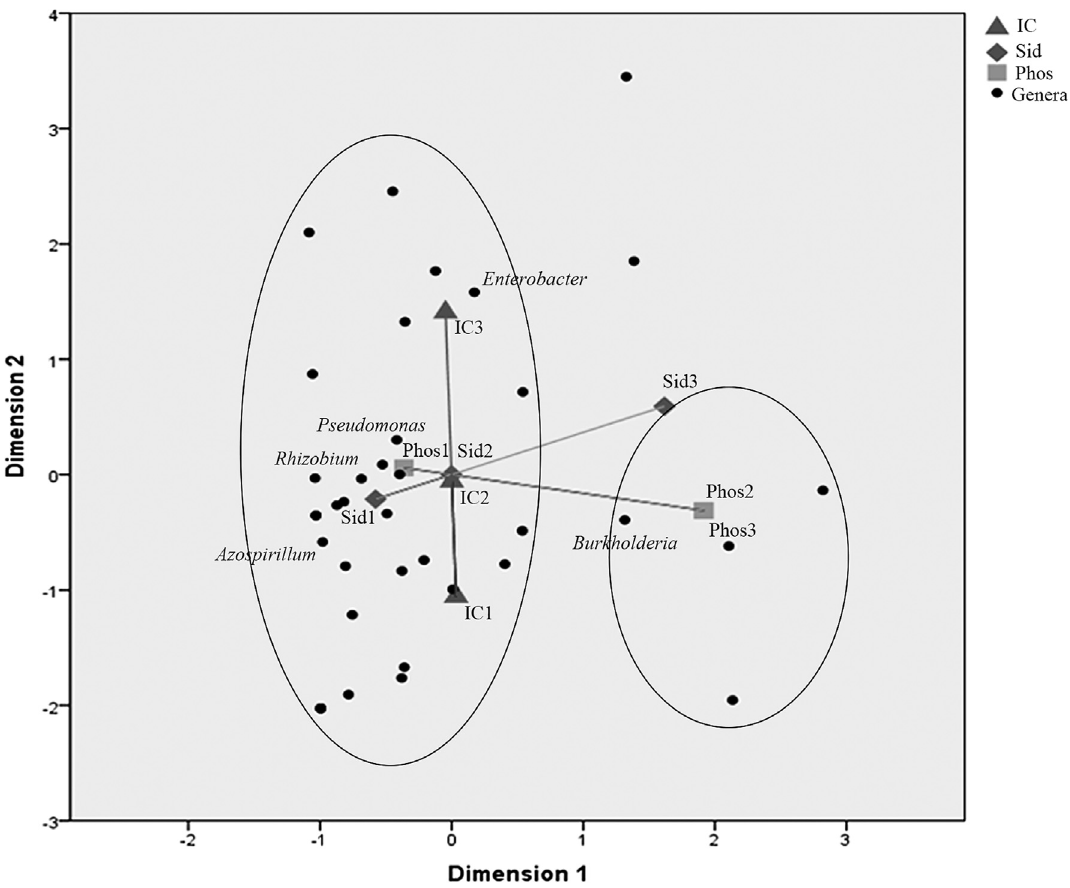
Figure 2 - Multiple Correspondence Analysis (MCA) of levels of PGP traits and genera. IC = indolic compounds production, Phos = phosphate solubilization, and Sid = siderophores production. Numbers following the abbreviation mean the level of the correspondent trait according with the score established. Dark spots represent all 36 genera identified; only the most abundant are identified in the